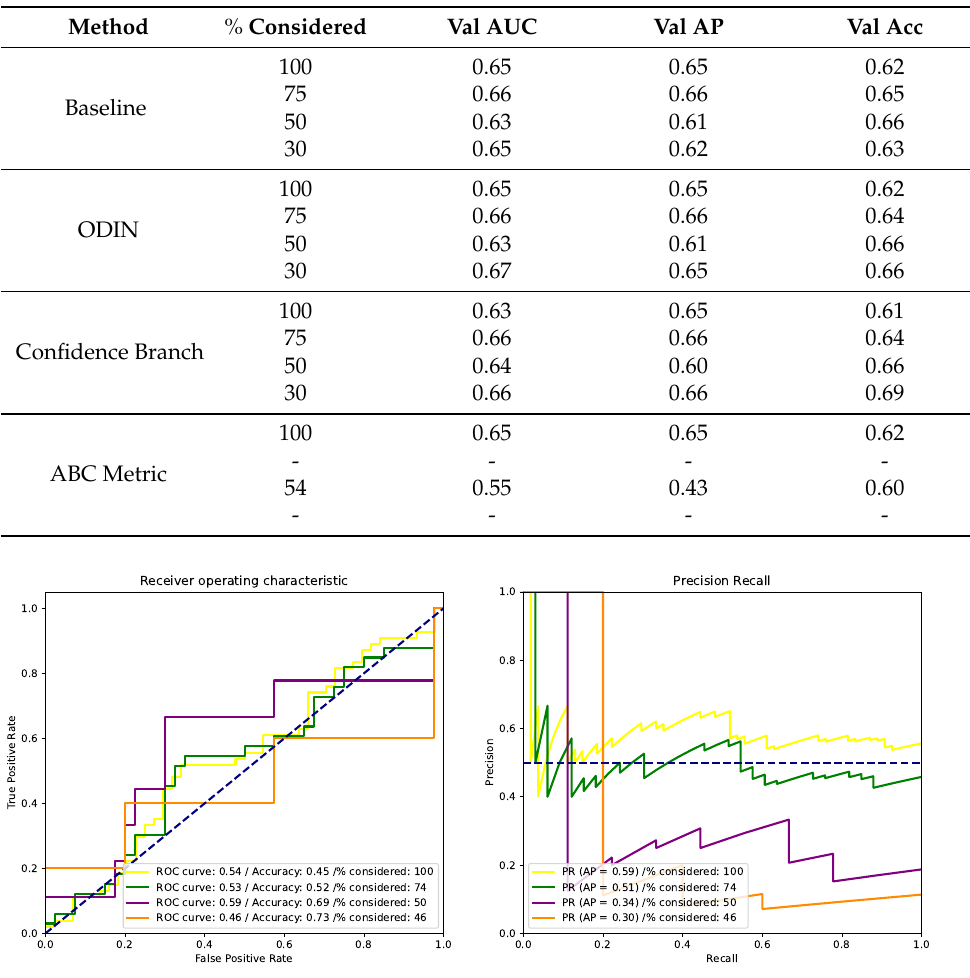
Figure A3. ROC and PR curves for the methylation percentage metric. FLAIR only. Table A2. Results of confidence metrics on the validation set. T1wCE